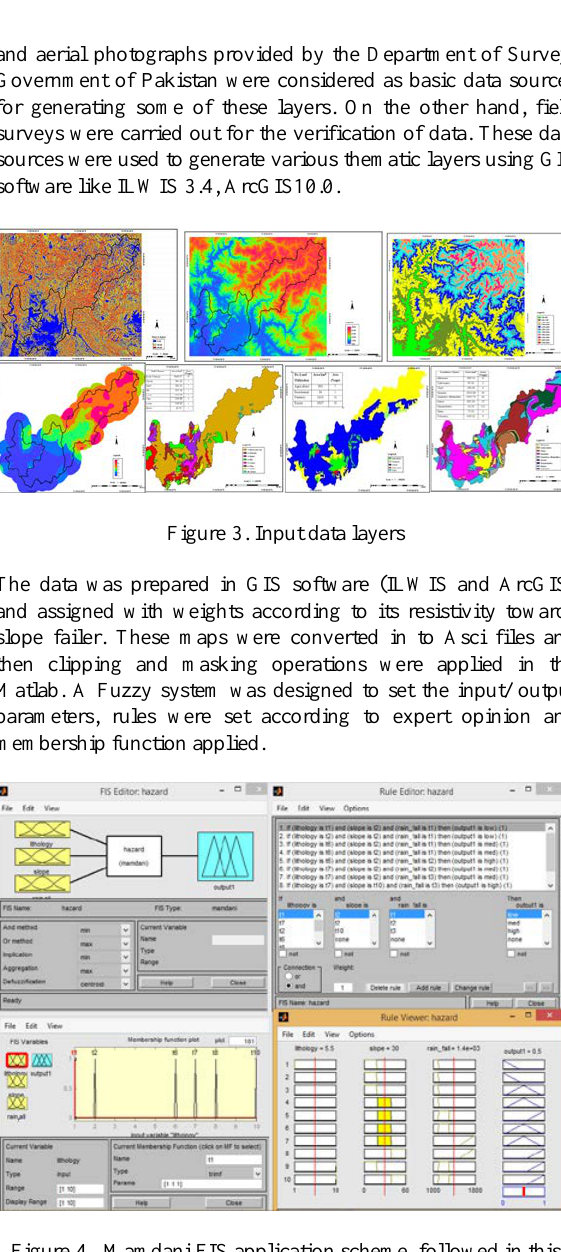
Figure 4.. Mamdani FIS application scheme, followed in this study